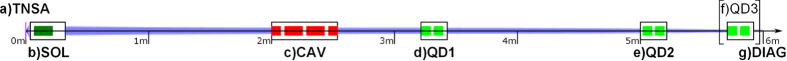
The setup of the current LIGHT beamline at GSI.(a) The PHELIX laser drives the acceleration of a broad proton spectrum up to 28.4 MeV energies via the TNSA mechanism. (b) A specific energy can be selected and collimated by a pulsed high-field solenoid, in this case 7.8 MeV protons, and the bunch is (c) rotated in longitudinal phase space within a rf cavity. Two quadrupole doublets, (d) and (e), provide for the beam transport up to (g), a diagnostic chamber at 6 m distance to the source. (f) represents an optionally third quadrupole doublet for a steeper final focusing of the bunch.